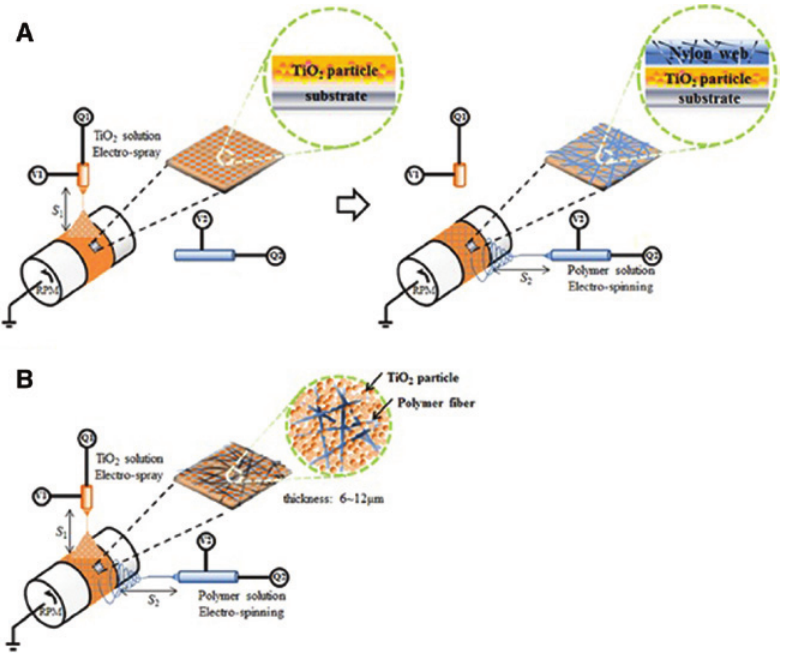
Figure 16: Schematics show the fabrication methodology to produce titania fiber membrane by (A) batch process and (B) continuous process. For details, see Ref. [68]; reprinted with permission from